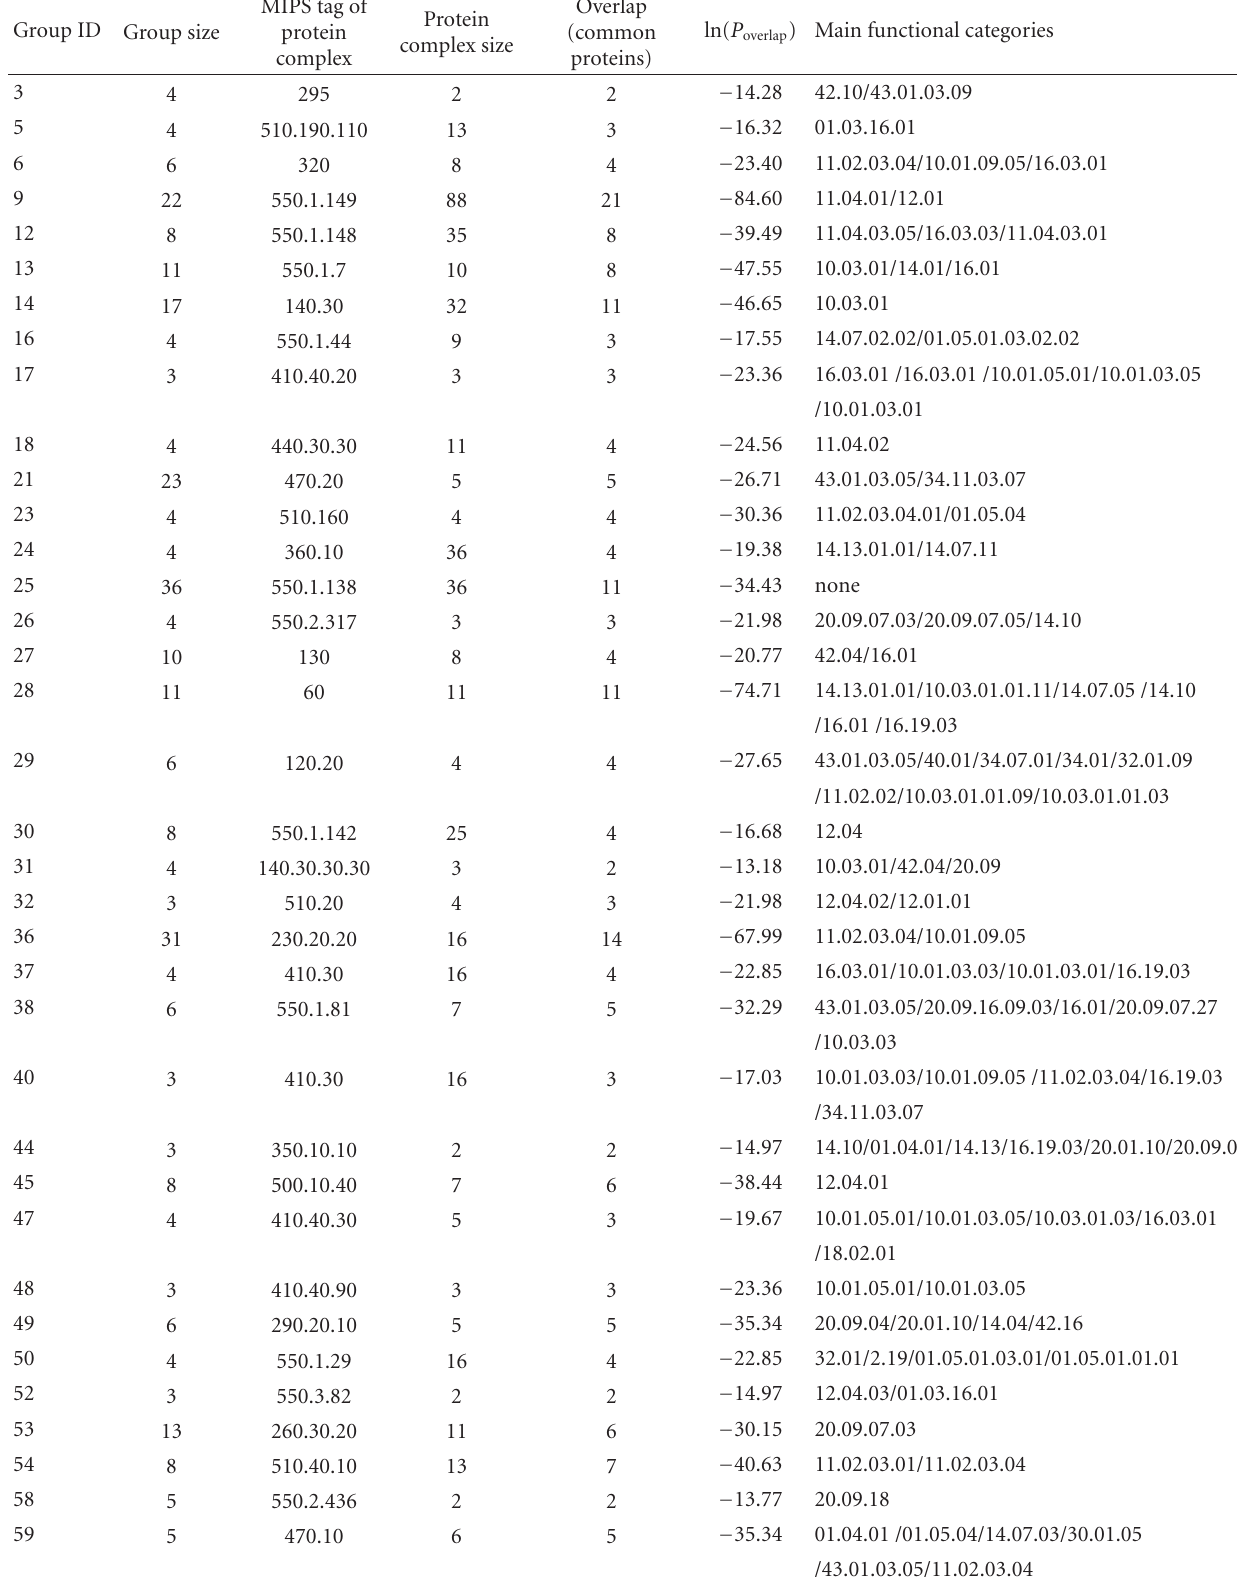
Table 3: The near-cliques matched with experimentally determined protein complexes cataloged in MIPS. The overlap column represents the number of proteins common to the near-cliques and the protein